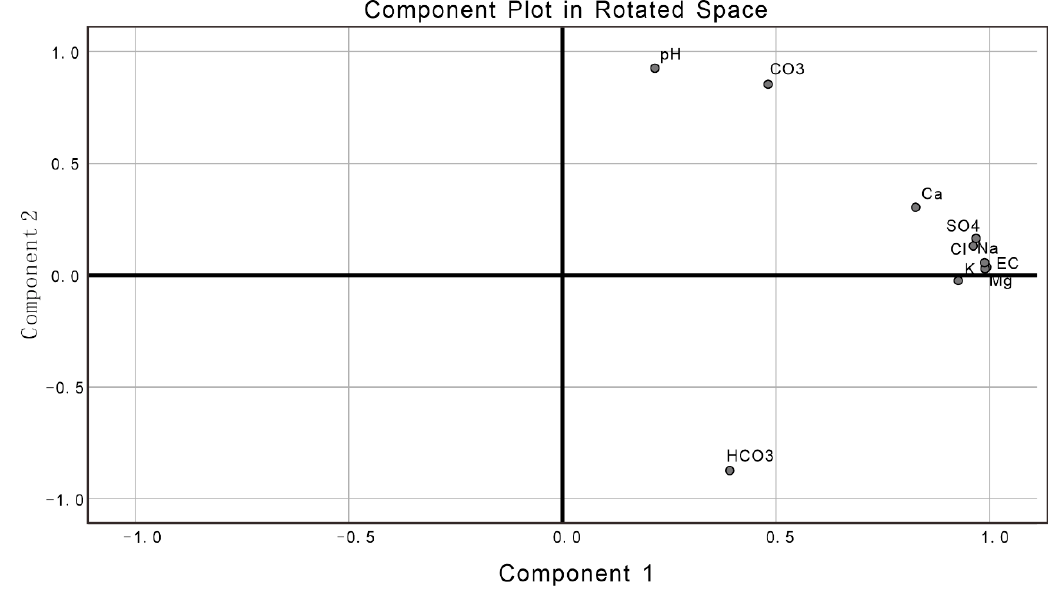
Figure 6. Loading coefficients for pH, EC and major ions in Bosten Lake water, based on factor analysis.